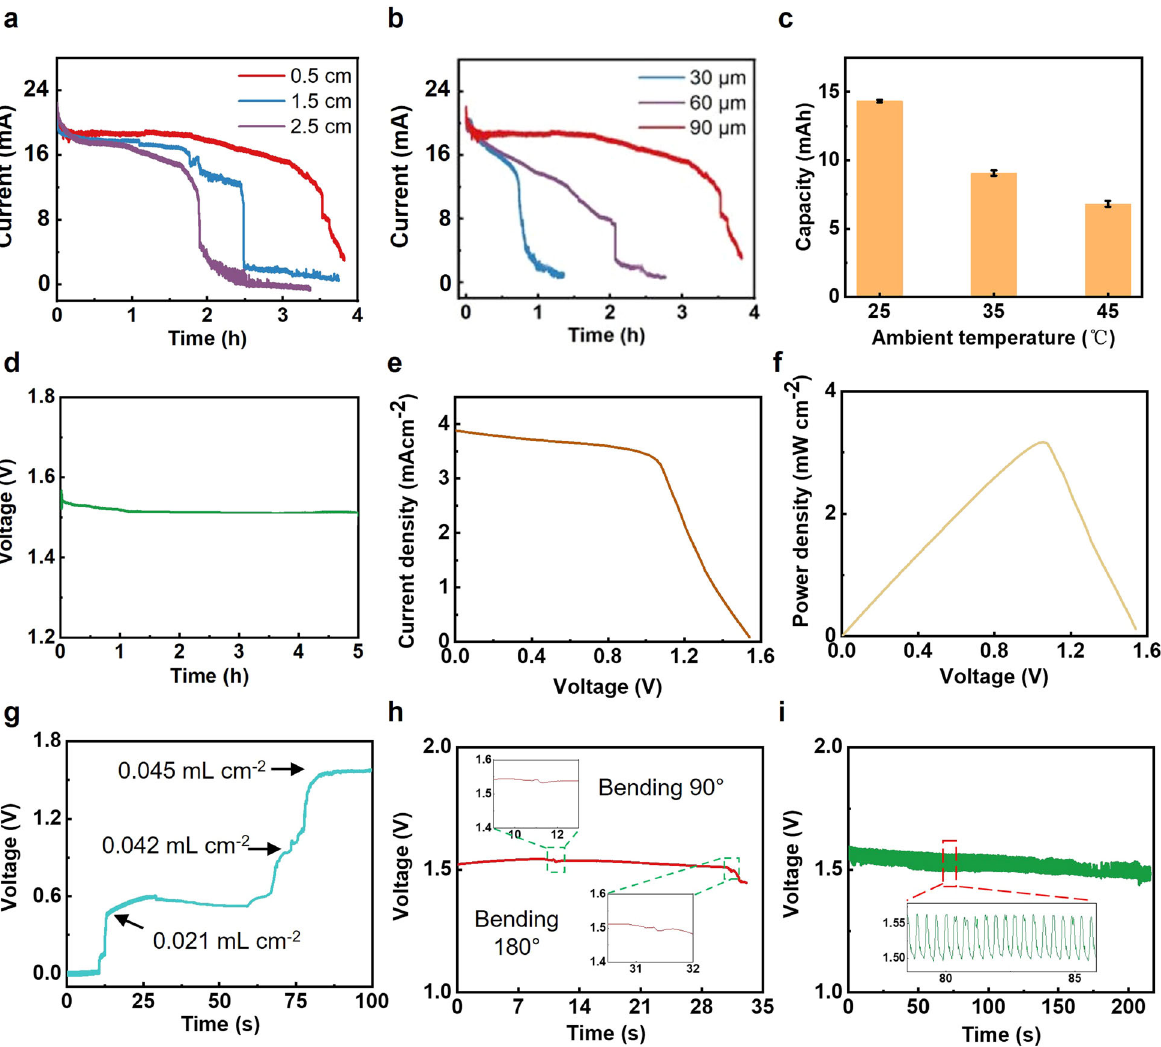
Fig. 2 Performance characterization of the SABs. a Short-circuit current of the SABs with three different electrode distances of 0.5, 1.5, and 2.5 cm, as a function of time. b Short-circuit current of the SABs with three different Mg foil thickness, 30, 60, and 90 μ m, as a function of time. c In fl uences of ambient temperature on the SABs ’ capacity. Discharging current, 1 mA cm − 2 . d Open-circuit voltage of the SABs. e Polarization curve of the SABs. f Power density curve of the SABs. g Electrical response of the SABs as a function of time with increasing injected sweat volume. h Electrical output response of the SABs bended as 90° and 180° as a function of time. i Electrical output response of the SABs bendeing over 600 times as a function of